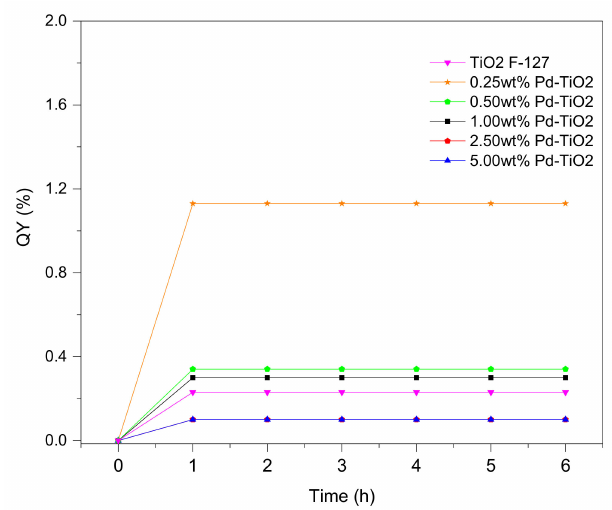
Figure 11. QY% at Various Irradiation Times under Visible Light using a 0.15 g / L of Photocatalyst Concentration. Note: Pd-TiO 2 photocatalyst with di ff erent palladium loadings: 0.25, 0.50, 1.00, 2.50, and 5.00